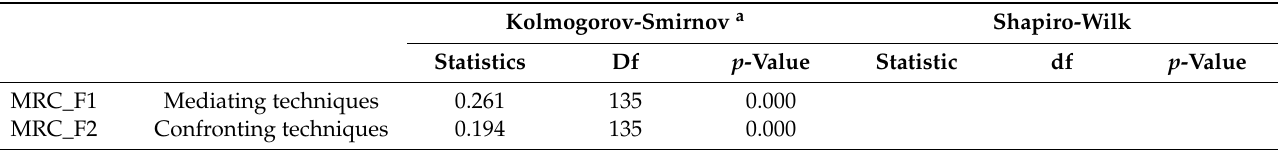
Table 7. Normality Tests for the